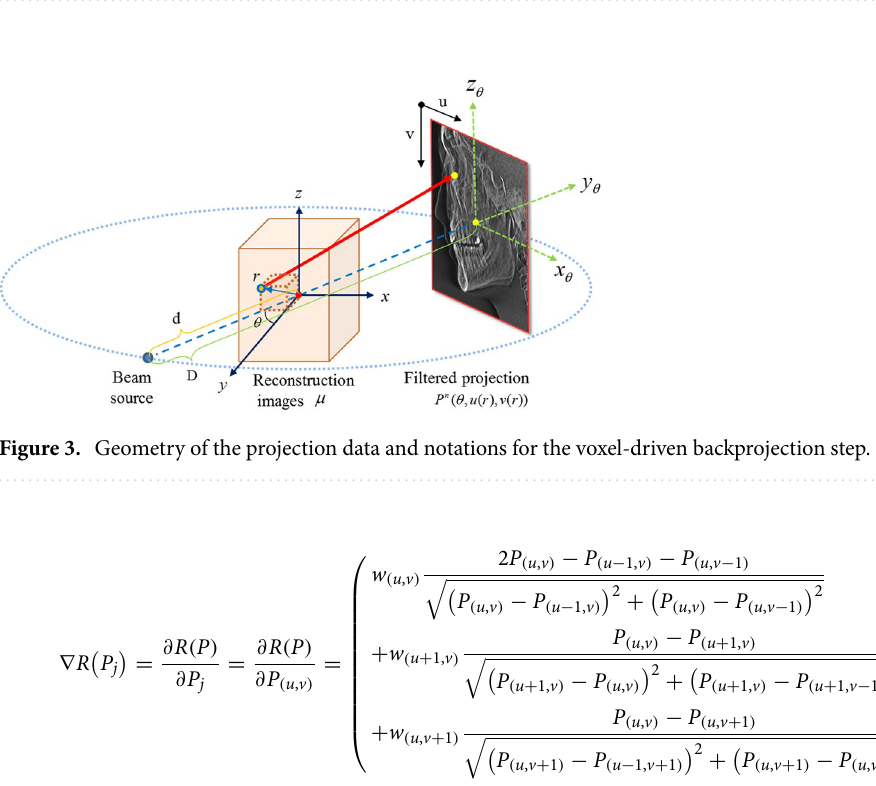
Figure 2. Comparison of filtered projection without (left) and with (right) the NLTV denoising algorithm.